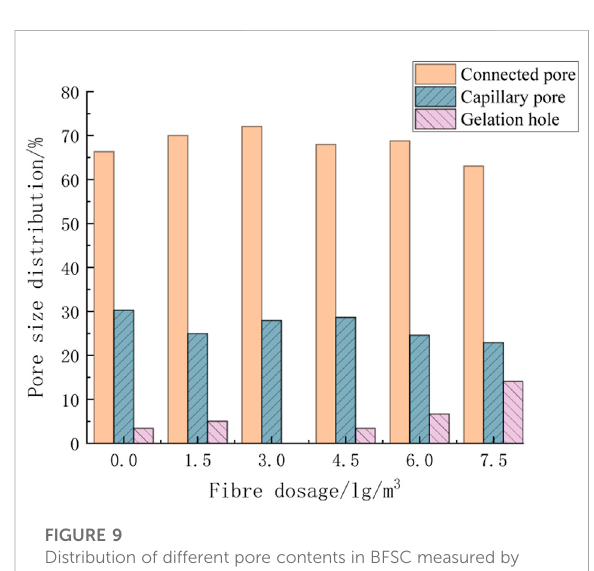
FIGURE 9 Distribution of different pore contents in BFSC measured by NMR (Jiao et al.,